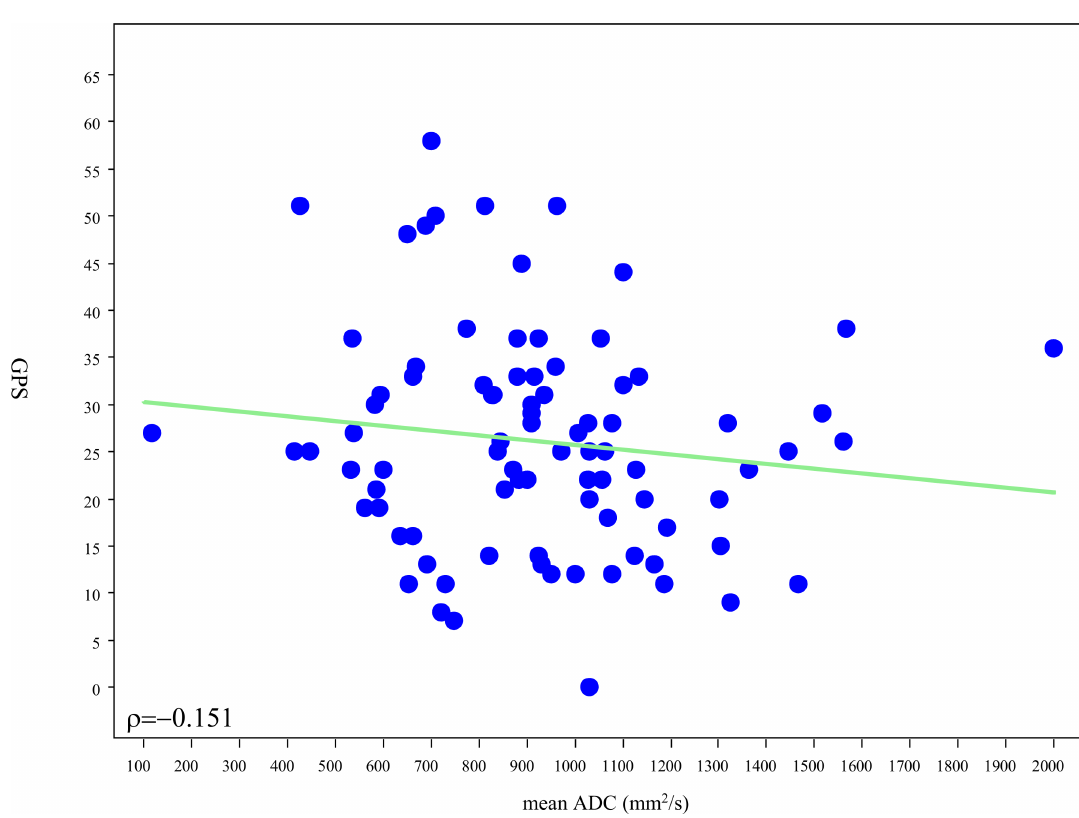
Fig 3. Relationship between meanADC value (mm 2 /s) of the dominant MRI lesion and GPS